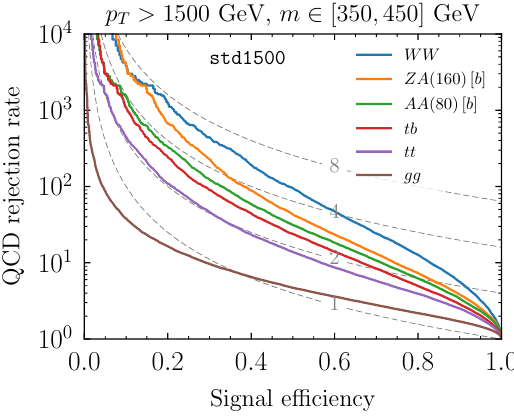
Figure 2 . Signal e(cid:14)ciency versus background rejection for the std1500 anti-QCD tagger. Signi(cid:12)- cance improvement due to shape-variable tagging is indicated by the dashed grey